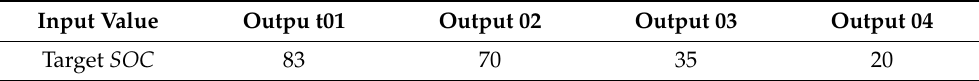
Table 3. Output parameters of the ANN-based model.